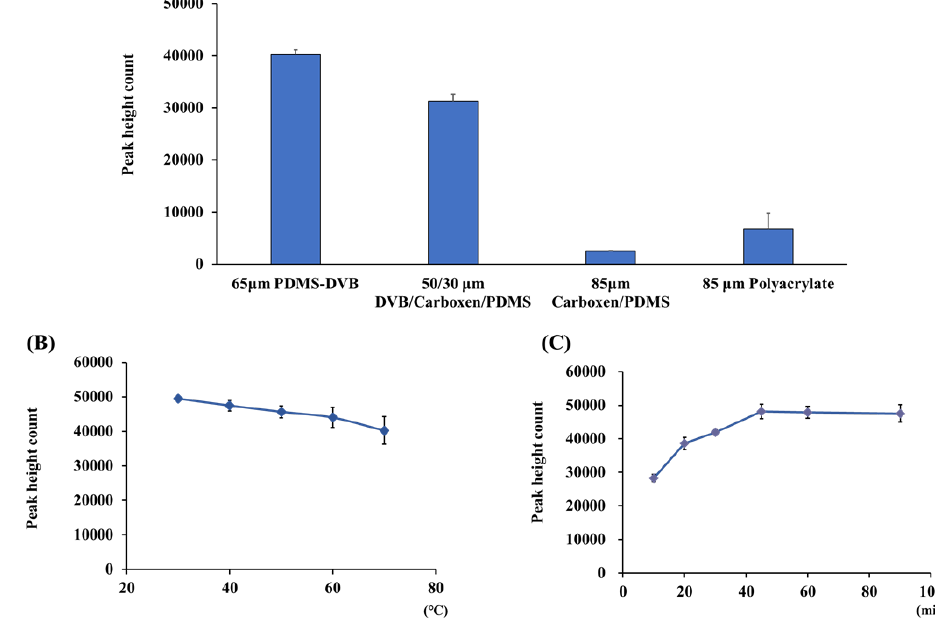
Figure 2. Effects of ( A ) fiber coatings, ( B ) temperature, and ( C ) time on the HS – SPME of 2-nonenal. For HS – SPME, 100 ng of 2-nonenal in gauze was extracted by ( A ) fiber exposition at 50°C for 45 min, ( B ) for 45 min with PDMS-DVB, and ( C ) at 50 °C with PDMS-DVB.